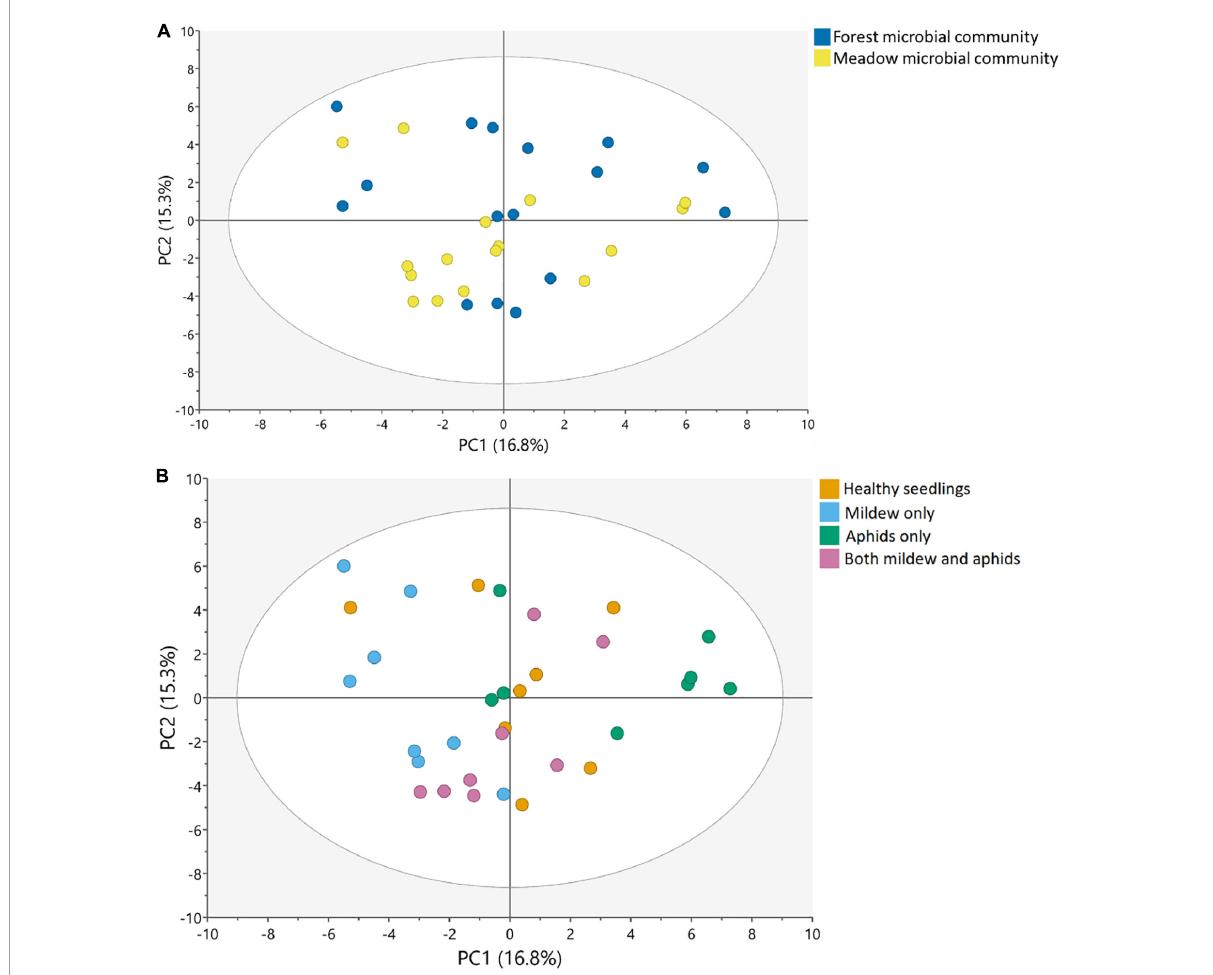
FIGURE1 Changes in the metabolic profiles of oak seedlings in response to (A) soil microbial communities and (B) attacker treatments, visualized in a score plot with the first two components of the PCA model, with the variation explained by the first component on the x-axis, and the variation explained by the second component on the y-axis. (A) Colors represent the different soil microbial communities, from forest and meadow, with 20 replicates per soil community (across attacker treatments). (B) Colors represent the different attacker treatments, including: (1) Healthy oak seedlings, (2) Seedlings attacked by mildew, (3) Seedlings attacked by aphids and (4) Seedlings attacked by mildew and aphids, with 8 replicates per treatment (across soil microbiomes) (for the loadings of these plots, see Supplementary Figure 6 ; for a visualization of the OPLS-DA model on attacker treatments, see Supplementary Figure 5